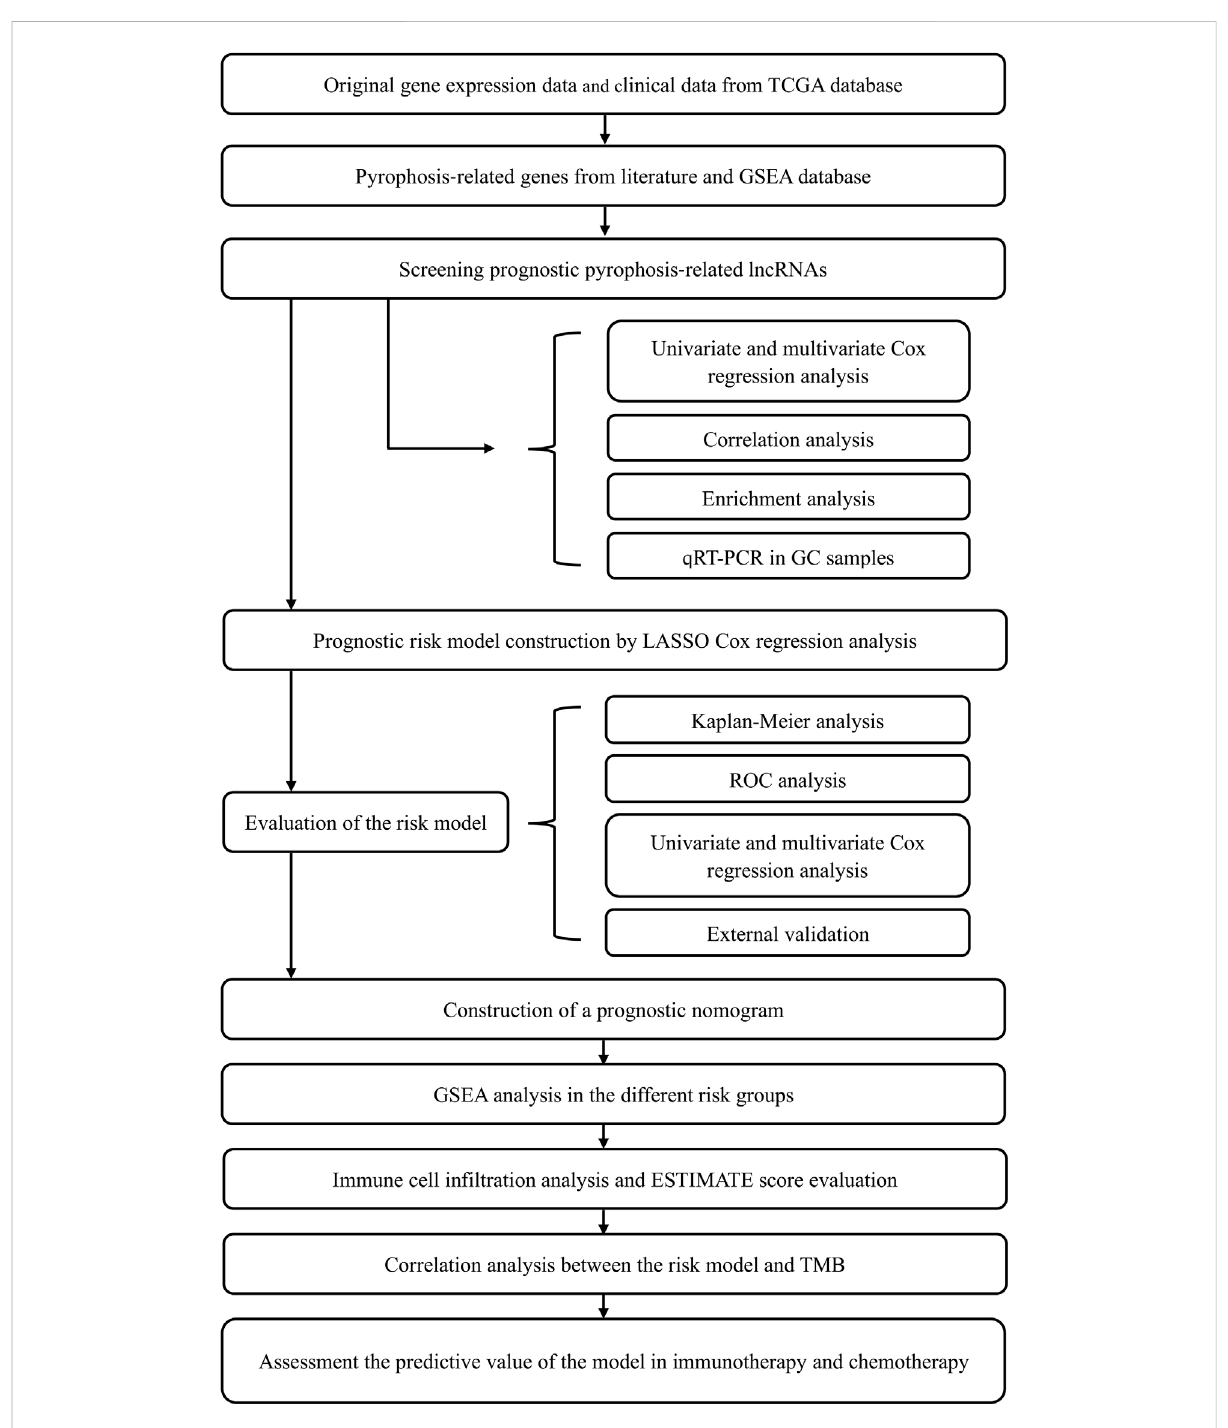
FIGURE 1 Flowchart of this